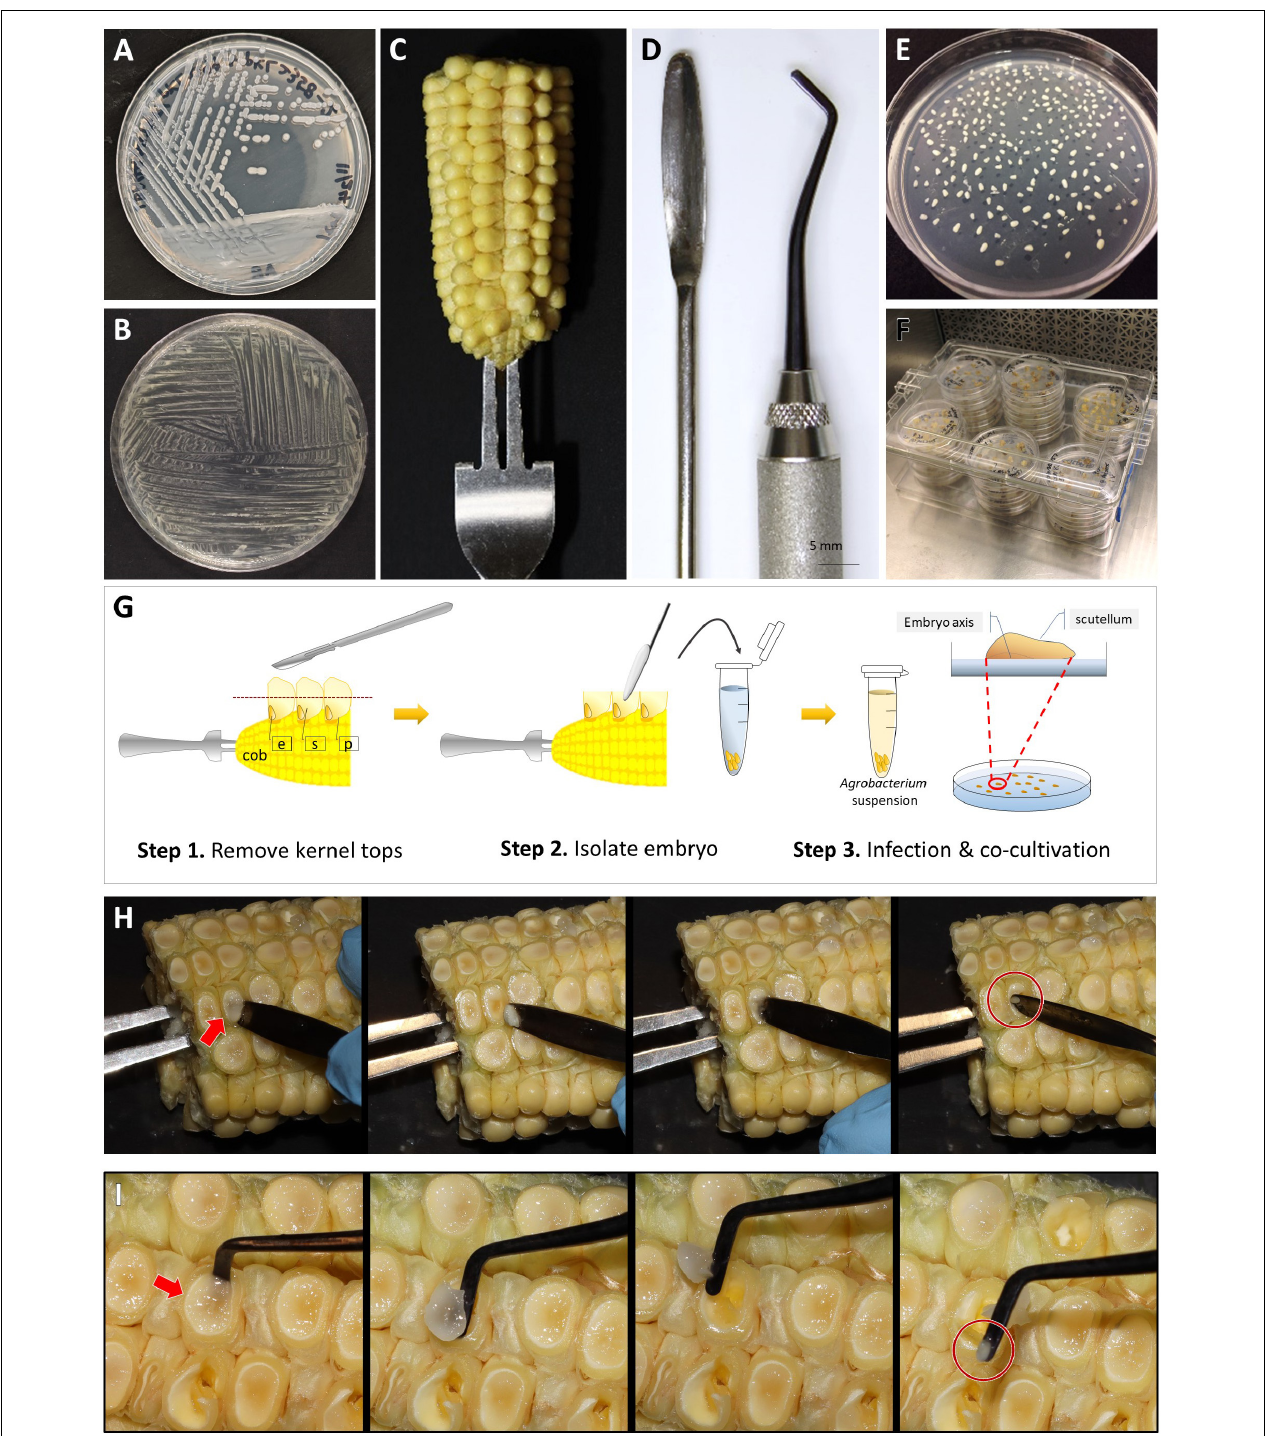
FIGURE 3 | Embryo dissection, infection, and co-cultivation. An Agrobacterium “mother” plate (A) and “working” plate after 18 h incubation, streaked by a disposable loop (B) . (C) A B104 ear halves on a handle made of a fork. (D) Tools for embryo dissection; a micro spatula (left) and a dental filling instrument (right). (E) A co-cultivation plate with dissected immature embryos. All embryos were re-oriented scutellum side up. (F) A plastic culture box filled with plates. (G) Cartoon illustration of the embryo dissection and infection process. Step 1, remove kernel tops using a sterile scalpel; Step 2, isolate embryo from the kernel and transfer it to a tube filled with liquid 700A infection medium; Step 3, after infection, place embryo onto co-cultivation medium and orient the embryos by placing them scutellum side up. e: embryo, s: endosperm, and p: pericarp. Demonstration of embryo dissection using a micro spatula (H) or a dental filler (I) . The arrows indicate the embryo side of the kernel. Circles highlight isolated